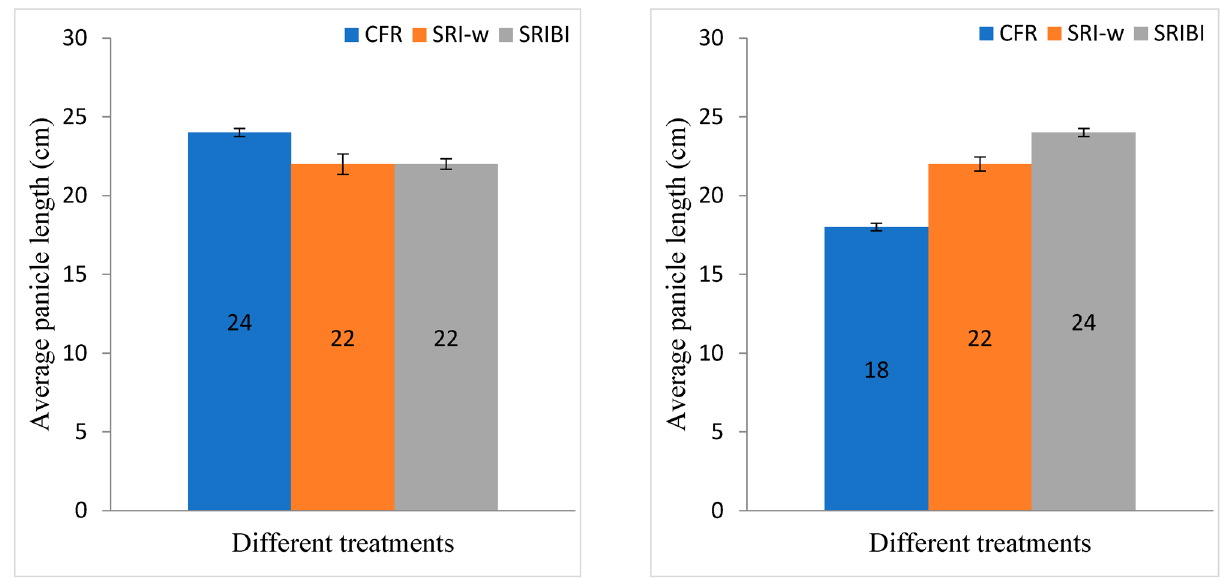
9 of 21 Table 6. Parameters from ANOVA statistical analysis for tiller number comparison. Tiller Number